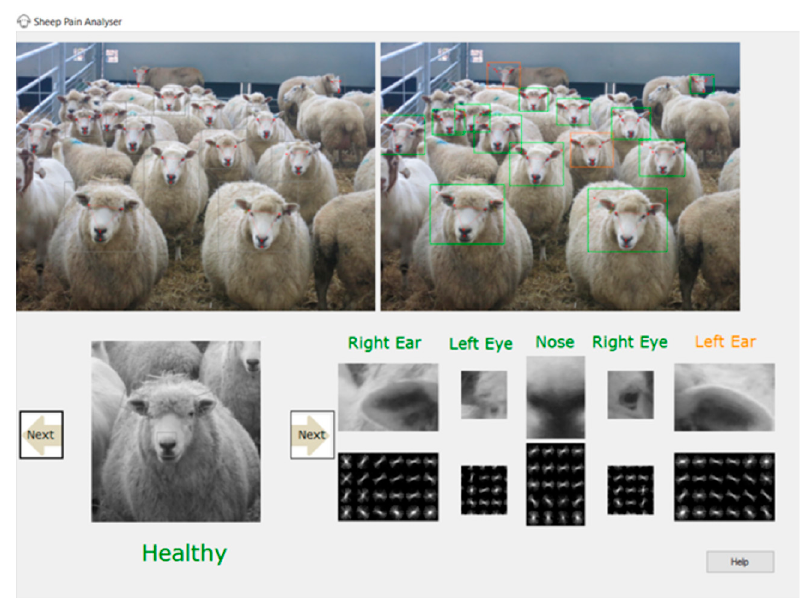
Figure 1. Pain analyser system prototype. Top left : photo of a flock of sheep, where sheep faces are automatically marked with boxes. Top right : facial expressions are automatically analysed using machine learning; animals with a probability of pain more than 50% are marked with an orange box while healthy animals are marked in green. Bottom : Every animal face is shown separately, and facial features are visualized, showing which areas in the face showed signs of pain. The final decision of the predictive model is based on the same scoring criteria of the Sheep Pain Facial Expression Scale (SPFES) scale.